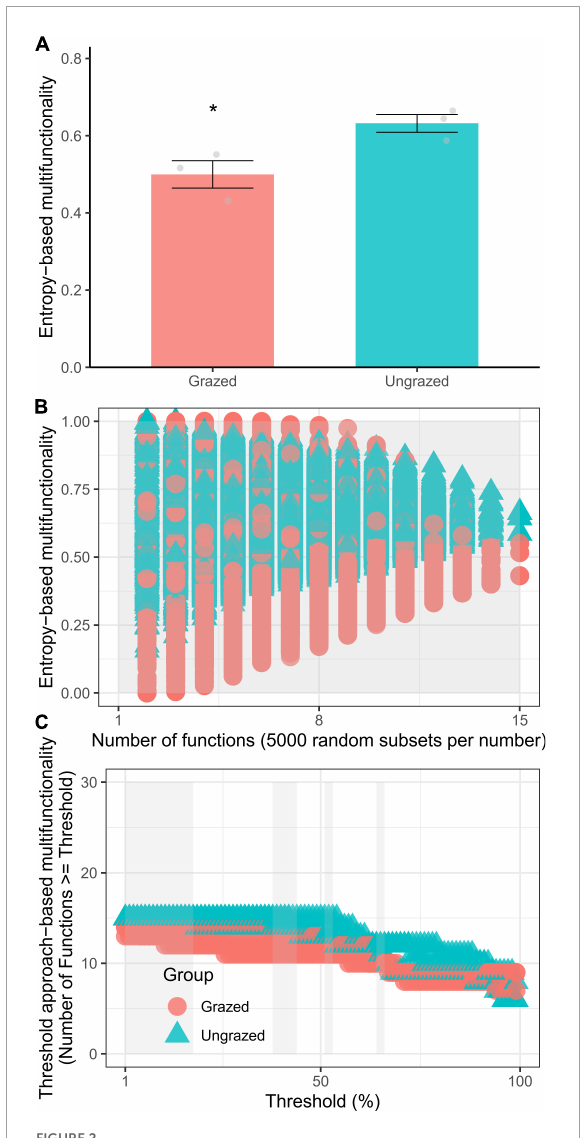
FIGURE2 The entropy-based multifunctionality [ (A) , considering maximum number of functions; (B) , considering the increasing number of functions] and threshold approach-based multifunctionality (C) of soils under grazed and ungrazed. * p < 0.05.